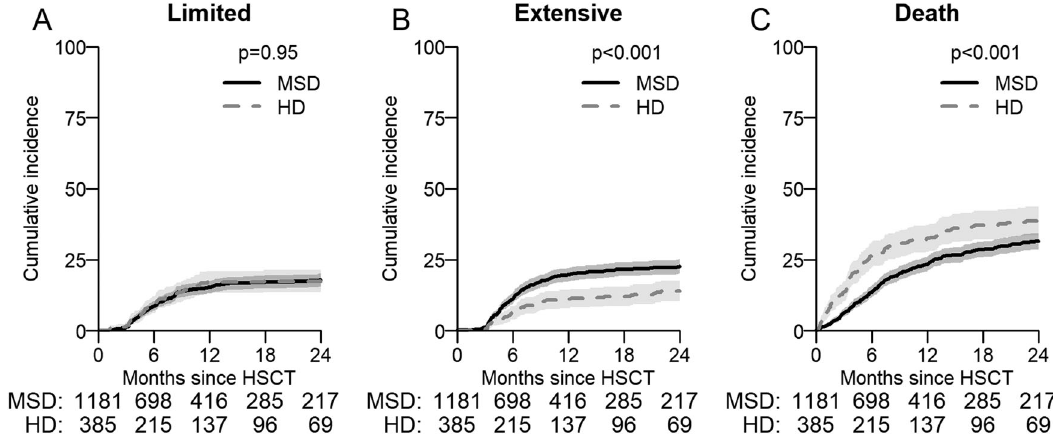
Fig. 3 Cumulative incidence of cGHVD. A Cumulative incidence of limited chronic GvHD until 2 years after transplant. B Cumulative incidence of extensive chronic GvHD until 2 years after transplant. D Cumulative incidence of death without cGvHD, C cumulative incidence of death due to